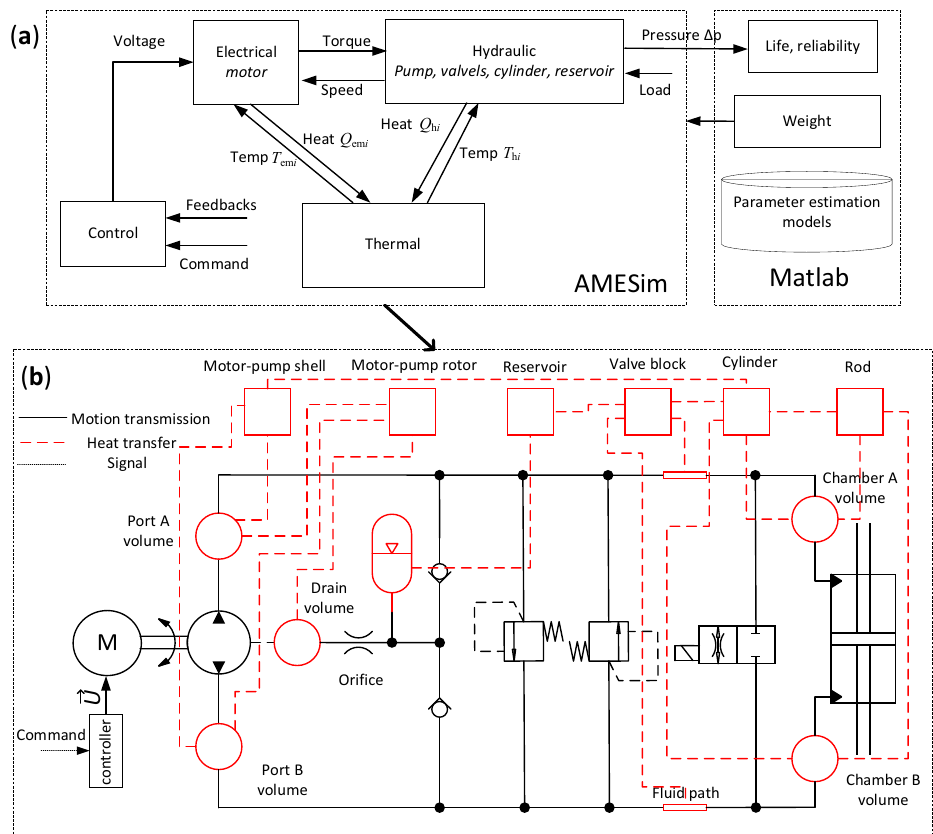
Figure 8. The holistic EHA model for the design verification. ( a ) The model architecture illustrating the discipline arrangement; ( b ) The object-oriented dynamic model of the EHA in AMESim.